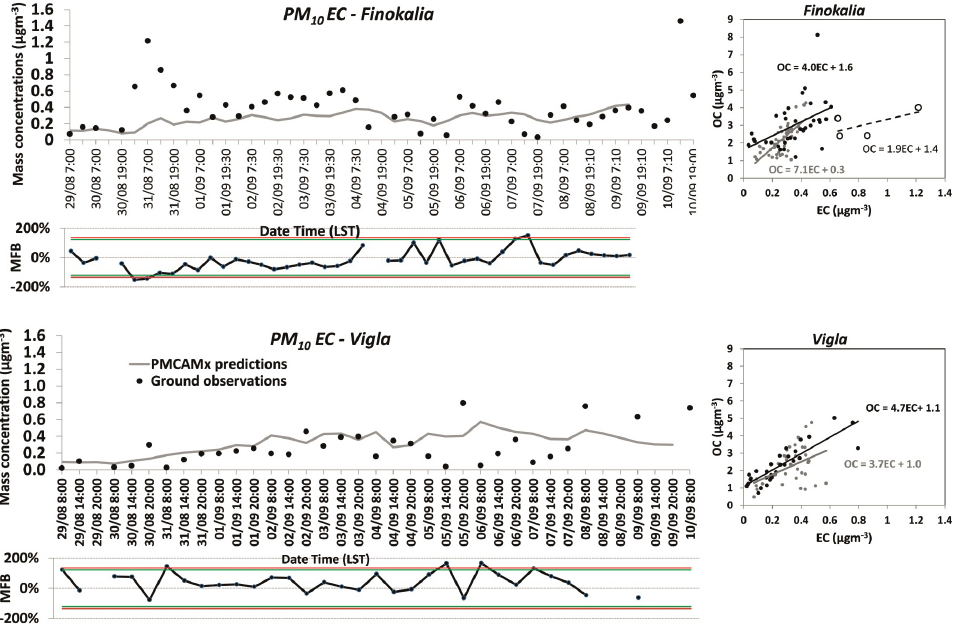
Figure 6. Comparison of PMCAMx (grey lines) with 6-h measurements (black dots) of PM 10 elemental carbon concentrations (µgm − 3 ) over Vigla (top) and Finokalia (bottom) during 31 August–09 September 2011. The ability of the model to reproduce observations is estimated through the calculation of the mean fractional biases (MFB), shown at the bottom of each graph. Model performance is average (good), when MFB values are within the red (green) lines (Boylan and Russell, 2006). OC versus EC (grey/PMCAMx and black/measurements data points and lines) in PM 10 is shown on the right of each graph. The black dashed line in Finokalia reflects the slope of OC to EC for the measurements during the NW transport from continental Greek sources (black empty circles, 31 August